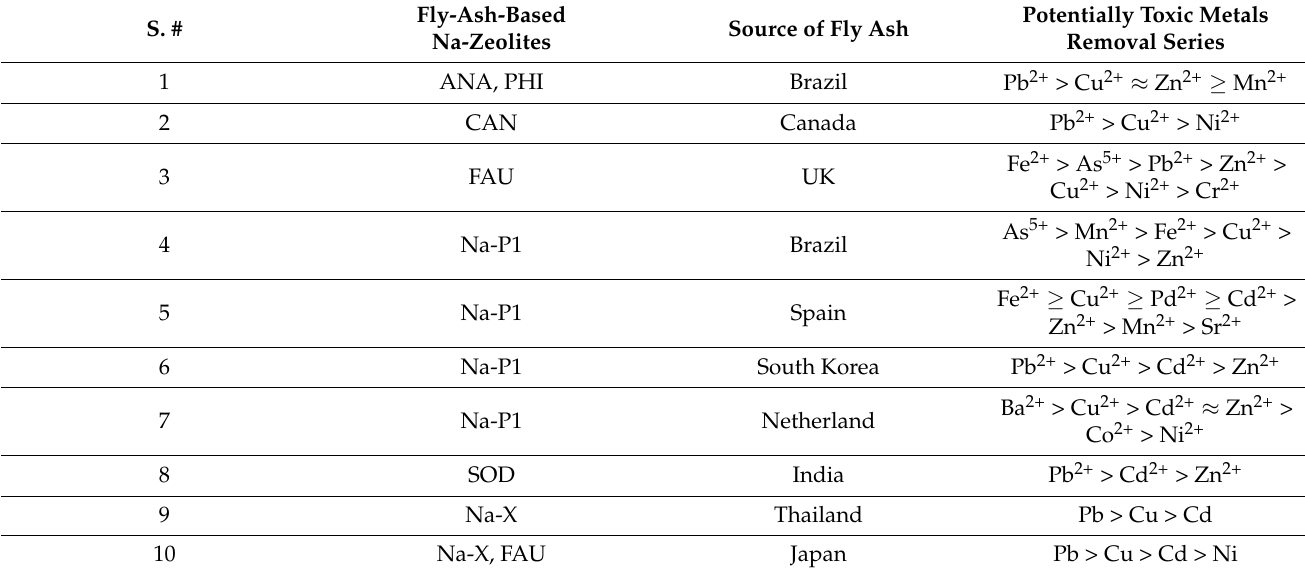
Table 3. Applications of fly-ash-based Na-zeolites and their metal-removal potential. S. #